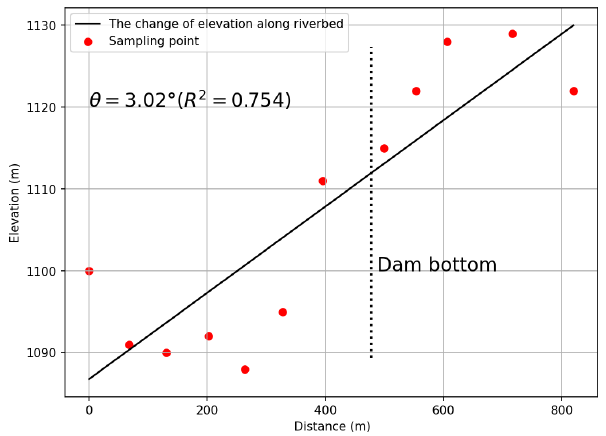
Figure 10. The change in elevation along the riverbed in the case of the Hongshiyan landslide